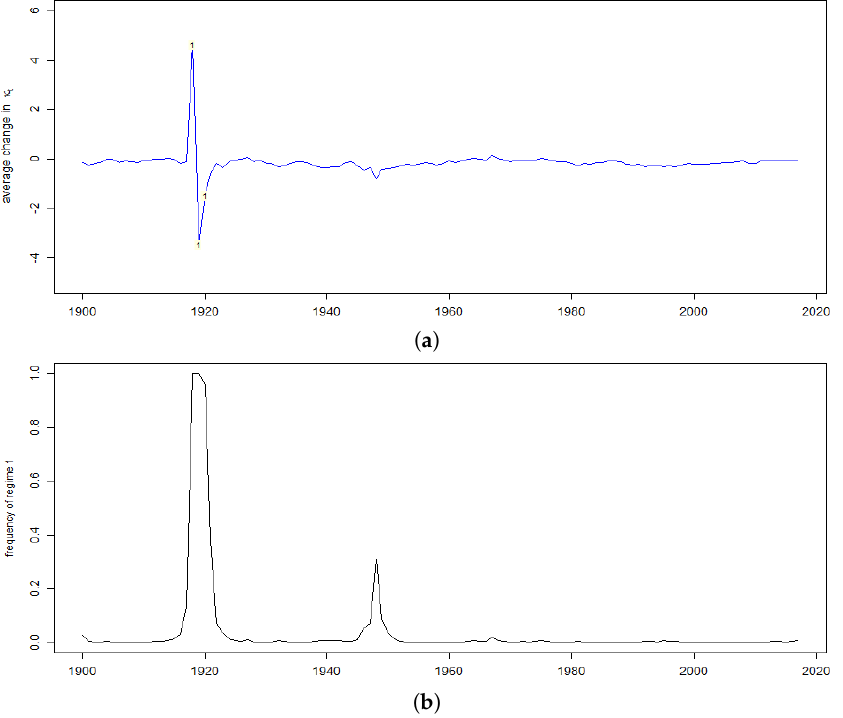
Figure 4. Average change in κ t time varying index over the recorded MCMC runs ( a ) and the average frequency regime 1 ( b ) for Sweden. Index “1” denotes the periods where the label of regime 1 is assigned in more than 50% of the recorded MCMC